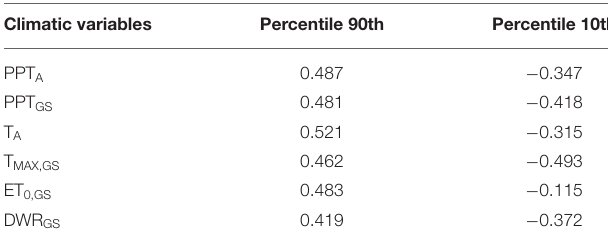
TABLE 4 | Values of the percentile 90th and 10th of the correlation coefficient between NDVI GS and each climatic variable included in Analysis 5. Climatic